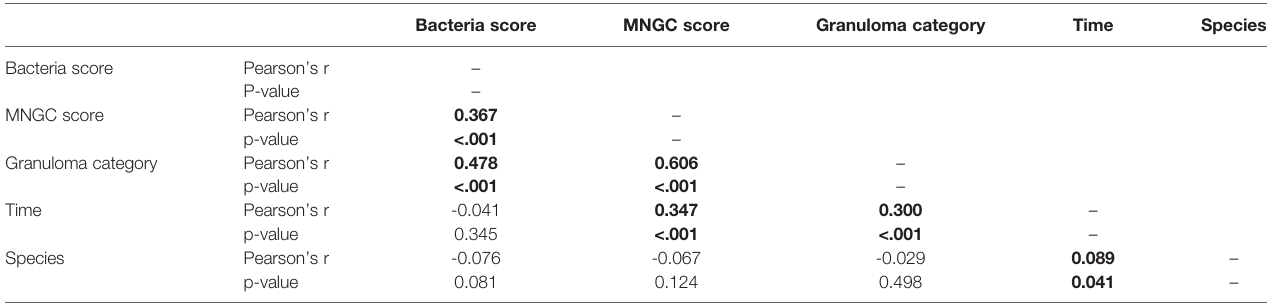
TABLE 5 | Correlation